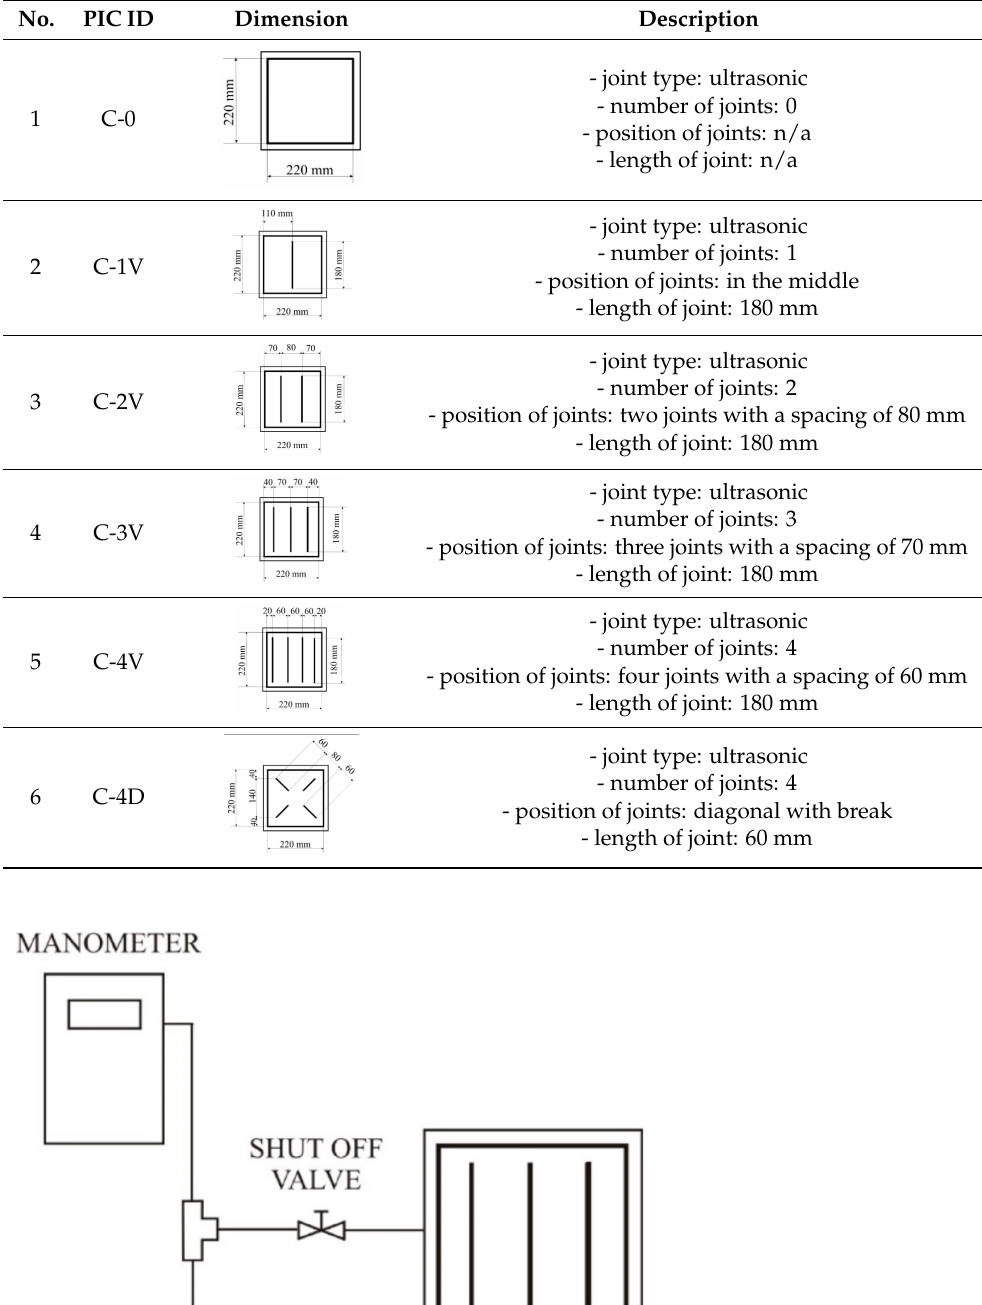
Table 1. Design of polyurethane insulation chambers (PICs). ID, identifier.